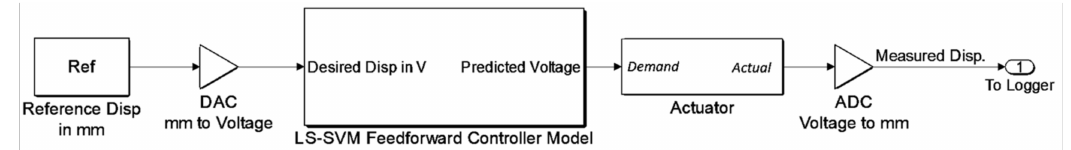
Figure 1. Feed-forward control of the actuator utilizing the trained least-squares support-vector machine LS-SVM